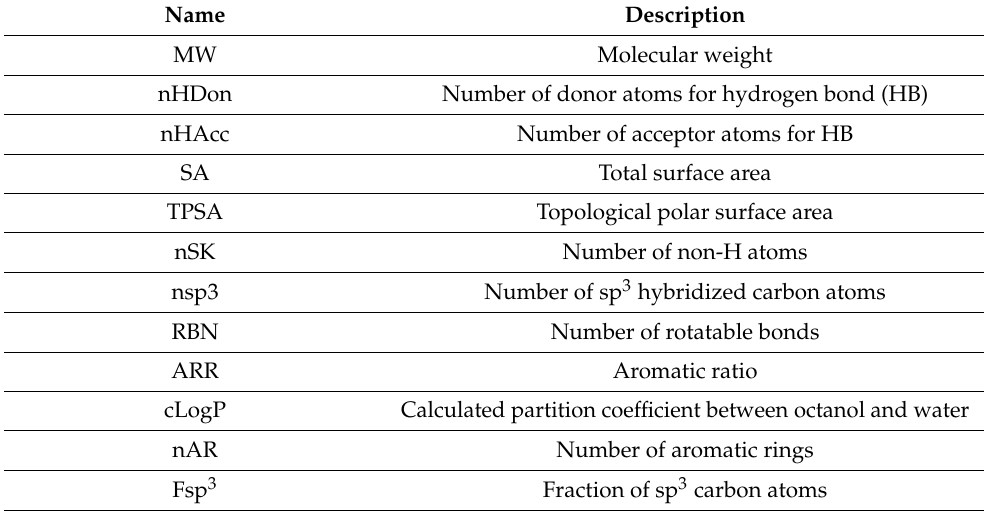
Table 1. List of studied molecular